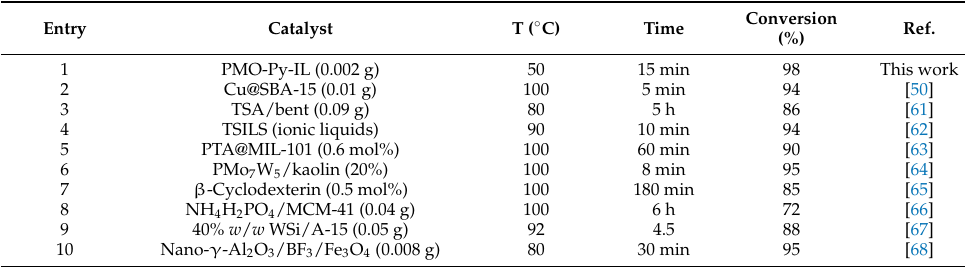
Table 3. Comparison of catalytic activities in the Biginelli condensation reaction of benzaldehyde, ethyl acetoacetate, and urea using heterogeneous catalysts under solvent-free